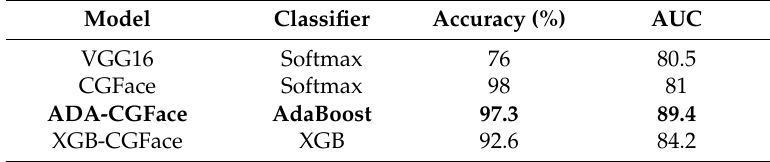
Table 3. The performance summarization of different models on PCGAN